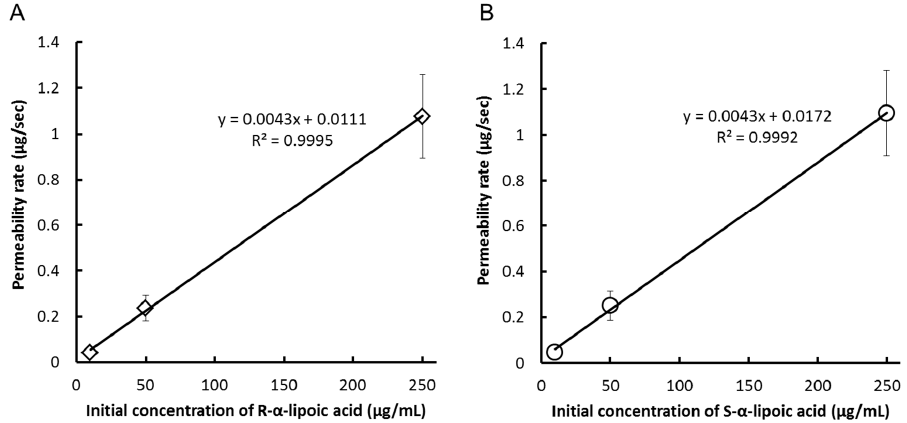
Figure 2. Correlation between initial concentrations versus permeability rate of ( A ) R- α -lipoic acid or ( B ) S- α -lipoic acid addition after addition of racemic α -lipoic acid to Caco-2 cell. Table 2. Calculated P app of Caco-2 cell by using the value of 15 min after addition of α -lipoic acid. Cell Types